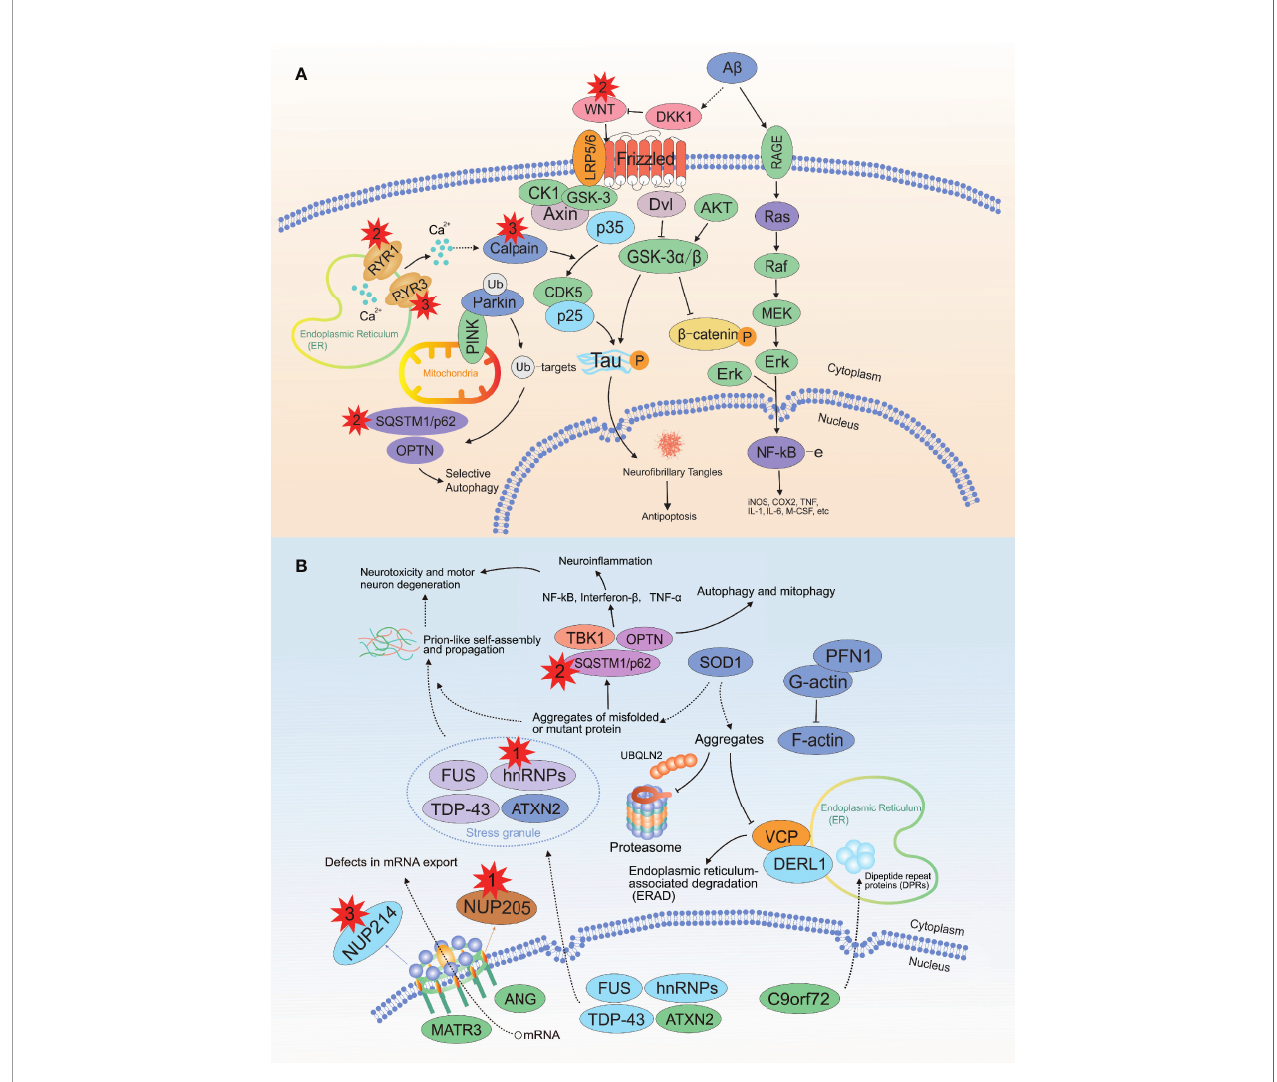
FIGURE 4 | Recurrent damaging variants of the neurodegeneration and ALS pathways in PDB. (A) There were two, three, and two mutations located in the WNT16 , RYR3 and RYR1 genes, respectively. (B) There were one, one, three and three mutations located in the HNRNPA2B1 , NUP205 , CAPN2 and NUP214 genes, respectively. ALS, amyotrophic lateral sclerosis; The red explosion patterns and numbers indicate the germline mutation type and frequency, respectively. The fi gure was produced by Adobe Illustrator Software (Adobe Systems, San Jose,